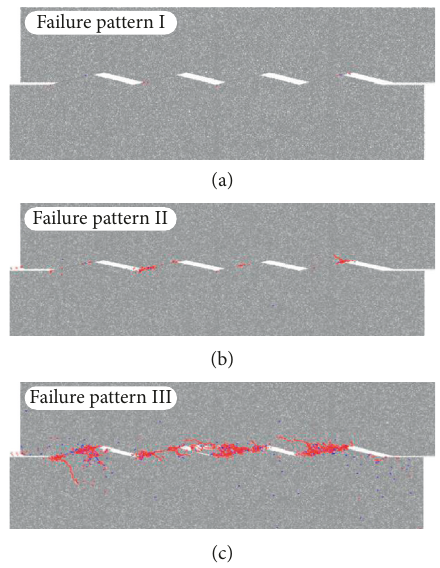
Figure 5: Shear modes of infilled joints. (a) Failure of the interface between rock and fillings, (b) sliding along the interface, and (c) the cutoff failure of the sawtooth. Red points: tensile crack and blue points: shear crack (adopted from Bahaaddini et al.,